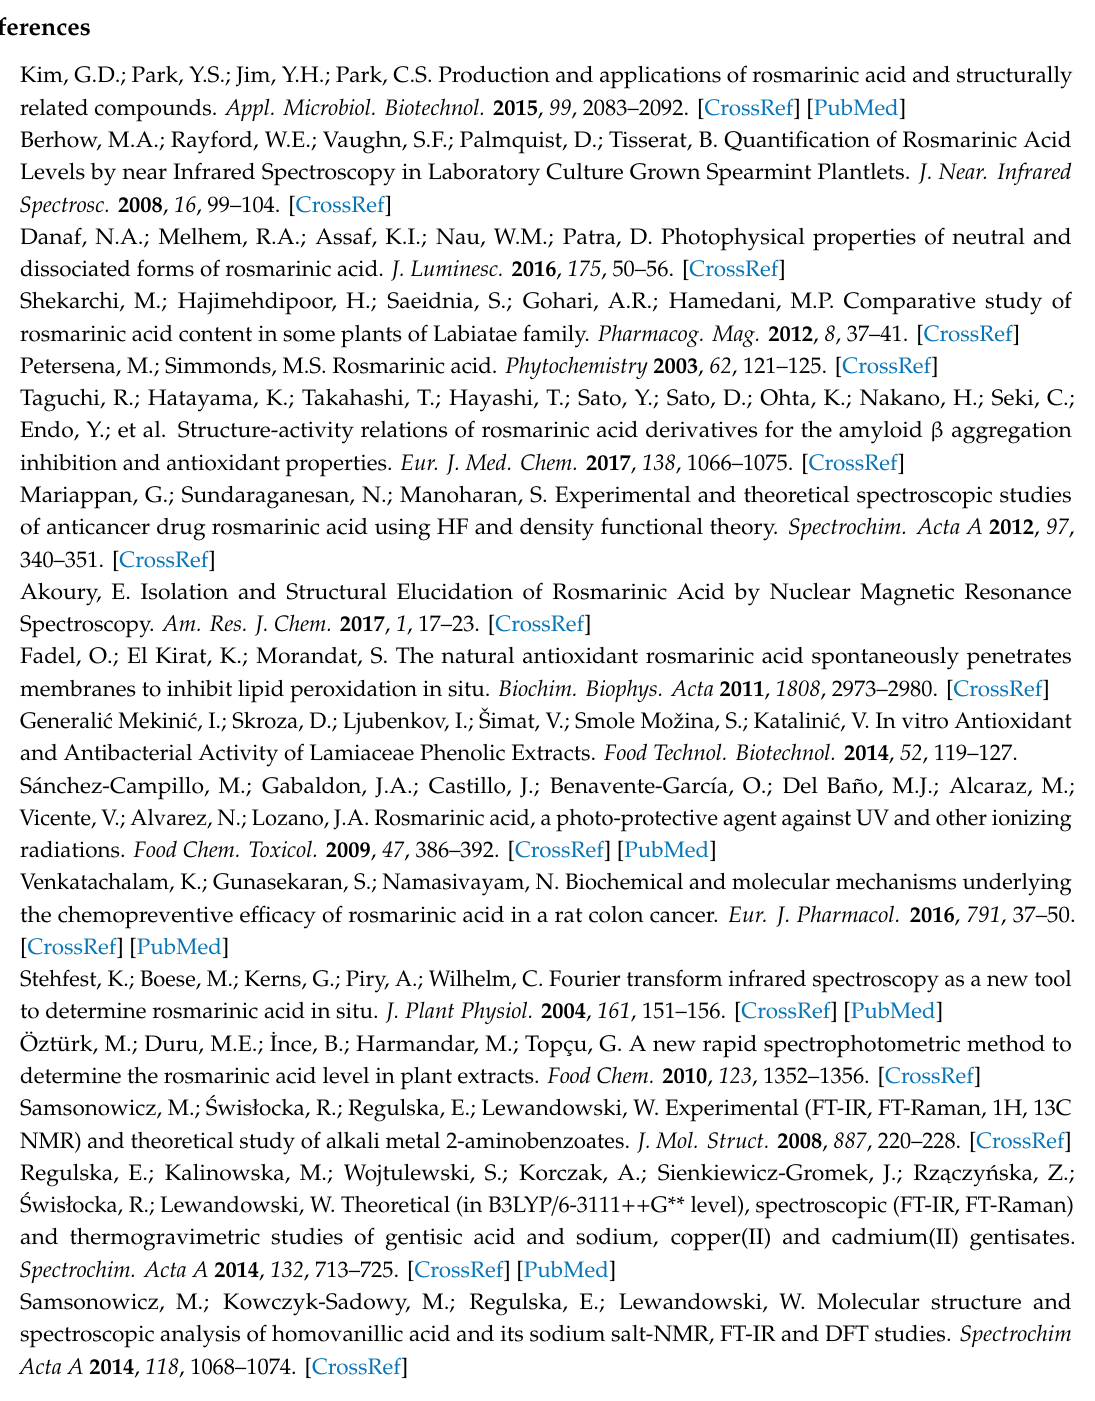
Supplementary Materials: The following are available online, Figure S1: The correlation between calculated and literature data of bonds lengths and